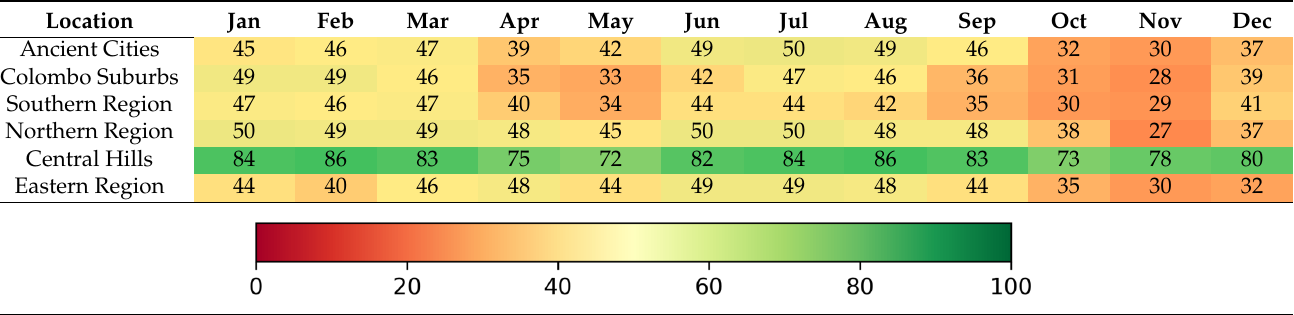
Table 2. HCI Urban values under measured climatic data (2010–2018).